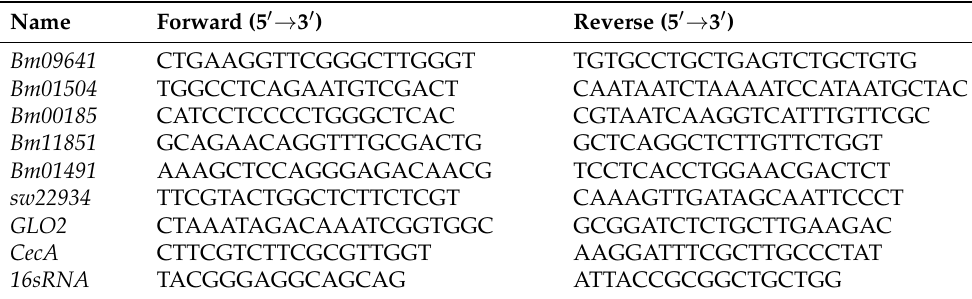
Table 1. Primer sequences for qRT-PCR in this study.